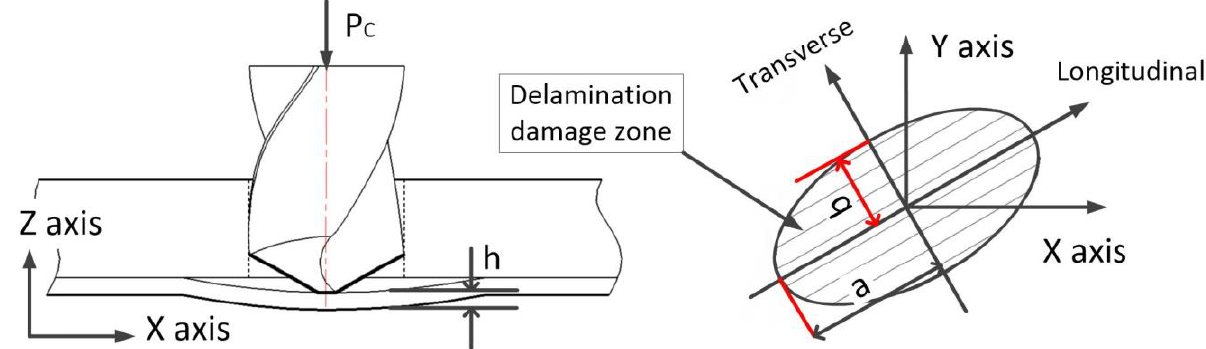
Figure 8. Force analysis of delamination damage at the exit of CFRP drilling.